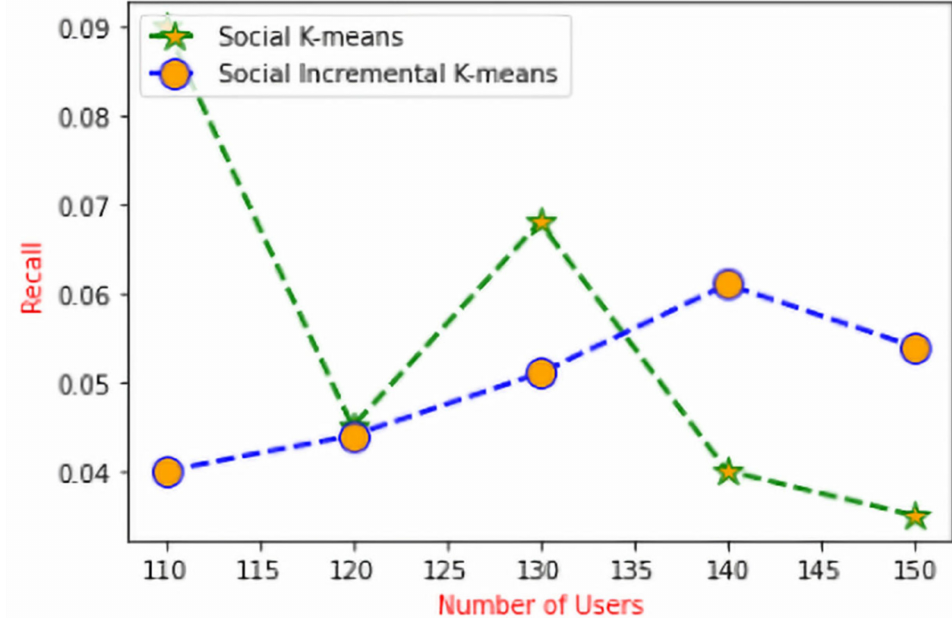
Figure 10. Recall—K-means versus incremental K-means algorithms with social information.